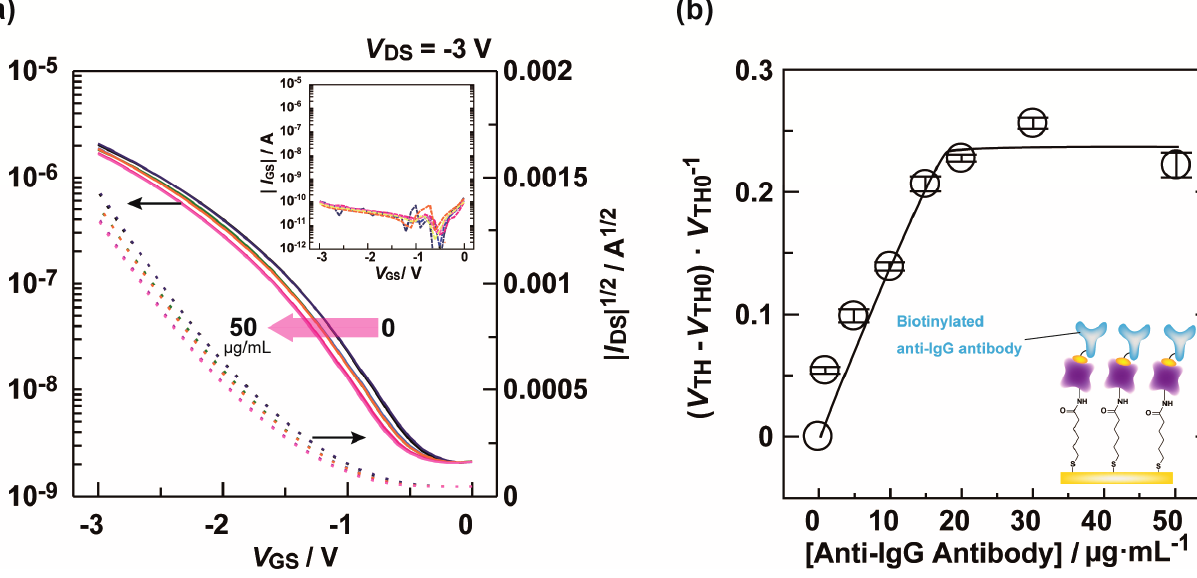
–V ) of the OFET upon titration with DS GS – V ); ( b ) Changes in threshold GS GS